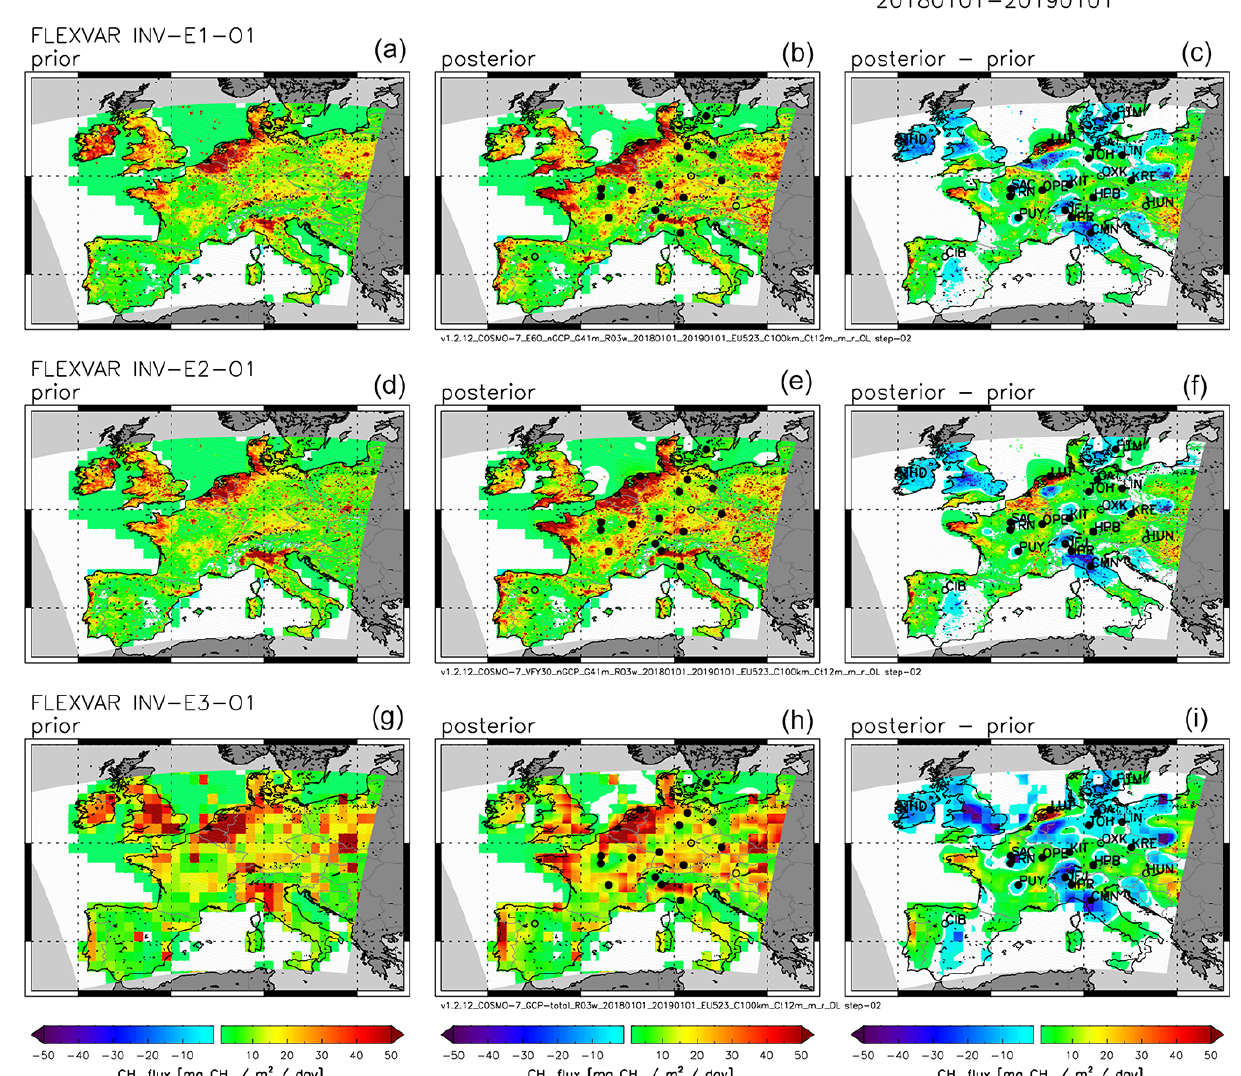
Figure 4. Sensitivity of FLEXVAR inversions to applied prior emission inventories. (a, b, c) Inversion INV-E1-O1 using emission data set E1 as prior estimate. (d, e, f) Inversion INV-E2-O1 using emission data set E2 as prior estimate. (g, h, i) Inversion INV-E3-O1 using emission data set E3 as prior estimate. (a, d, g) Prior emissions. (b, e, h) Posterior emissions. (c, f, i) Difference between posterior and prior emissions. All figures show annual average CH 4 emissions (or change in emissions, respectively) for